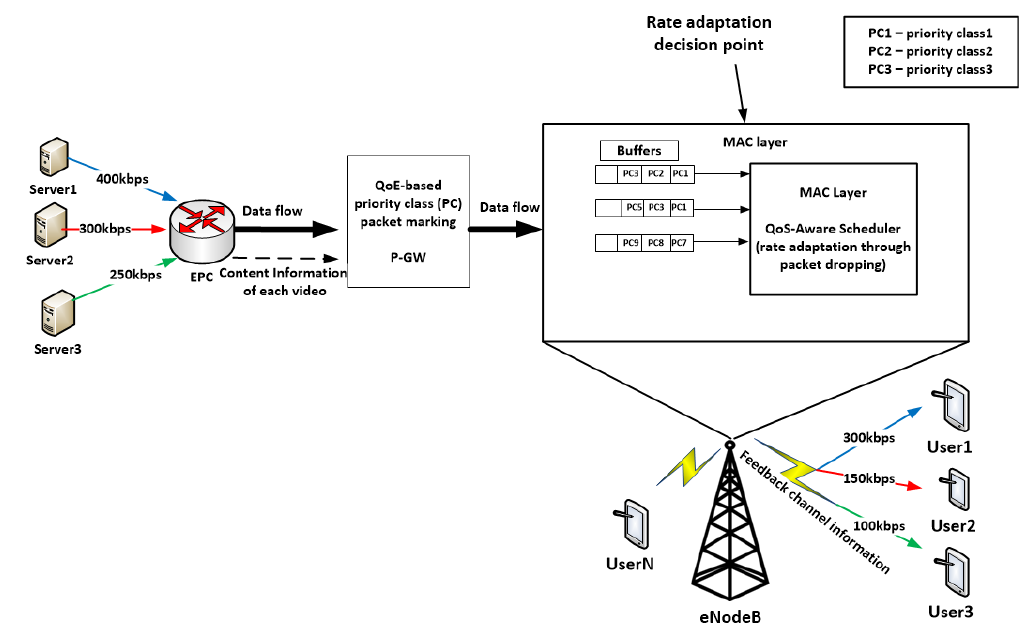
Figure 2. Quality of experience (QoE)-aware packet priority marking based